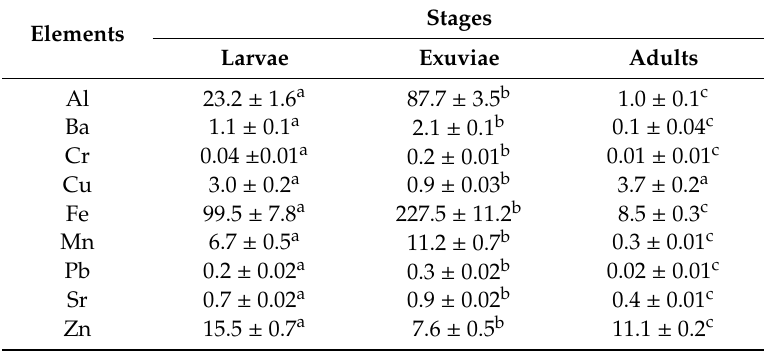
Table 4. Trace element contents per individual (expressed as mean ± standard error, unit: µ g) of G. flavipes developmental stages in the Tiszafüred studied area. Notations: di ff erent letters indicate the significant di ff erences at p <